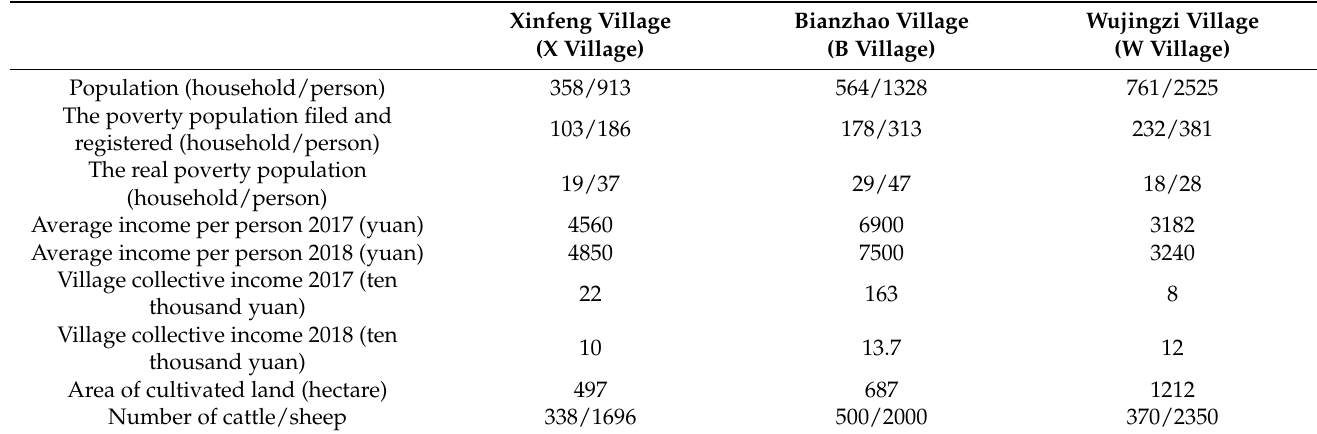
Table 1. The basic information of the case villages.